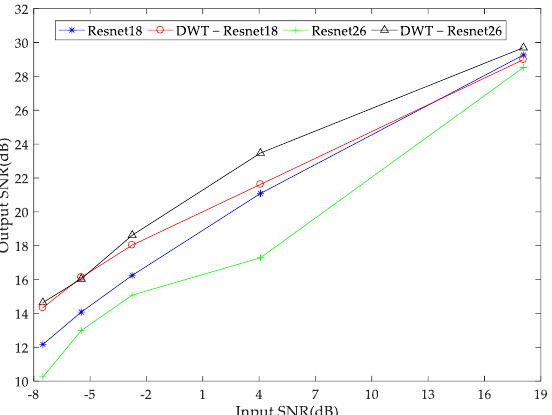
Figure 5. Comparison of denoising results using Resnet18, Resnet26, DWT−Resnet18, DWT−Resnet26 with different input SNRs.